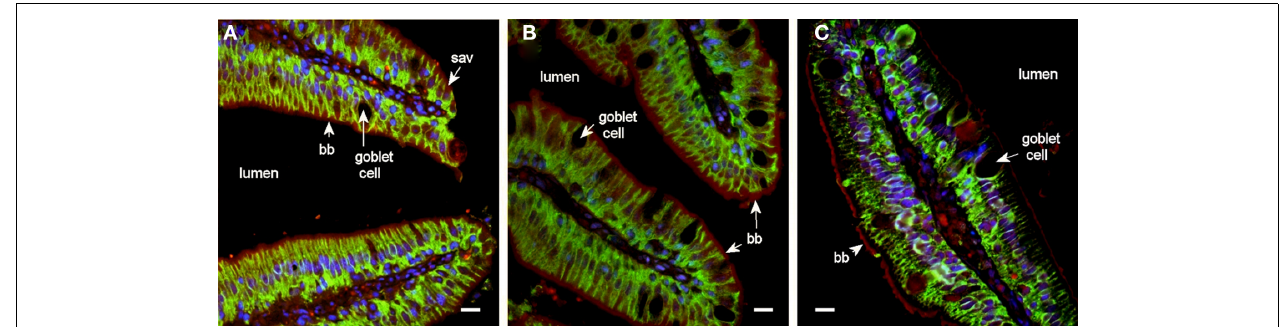
were counterstained with DAPI (blue). Lumen, goblet cells, nuclei, brush border (bb), and sub-apical vesicles (sav) are indicated. Note the distinct immunoreaction to all three aquaporins in the brush border and for Aqp1aa and − 1ab also in the sub-apical cytoplasmic domain. Size bar = 20 μ m.